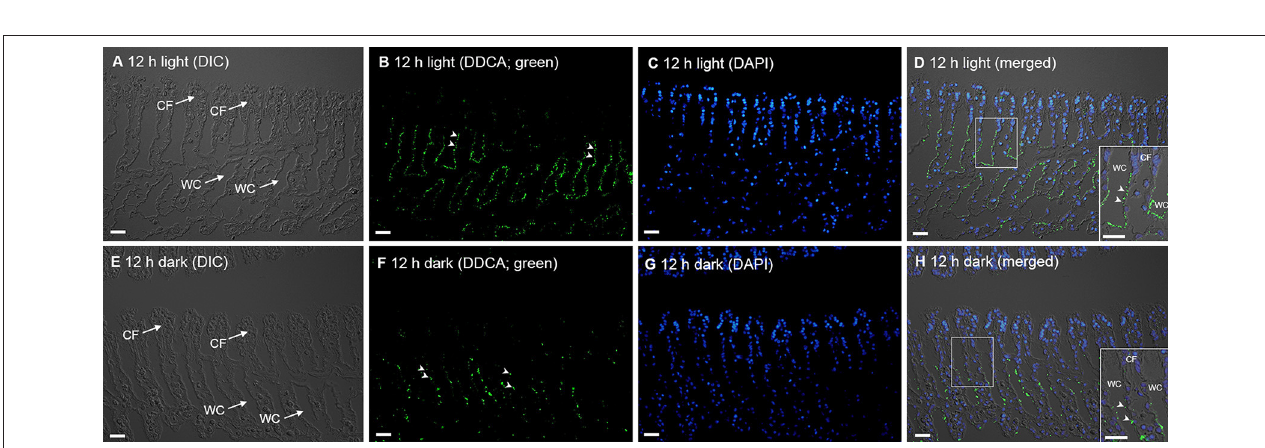
FIGURE 6 | Immunofluorescence localization of the Dual Domain Carbonic Anhydrase (DDCA) in the tertiary water channels (WCs) of the ctenidium of Tridacna squamosa . Immunofluorescence localization of the DDCA in the WCs of the ctenidium of T. squamosa exposed to 12h of light (A–D) or 12h of darkness (control; E–H ). Differential interference contrast (DIC) images show the lattice formation of WCs (A,E) . Anti-DDCA immunofluorescence is shown in green (B,F) with nuclei counterstained with DAPI in blue (C,G) . Green and blue channels are merged and overlaid with the respective DIC images (D,H) . Arrowheads indicate DDCA-immunostaining at the apical membrane of the epithelial cells surrounding the WCs. HL, hemolymph. Scale bar: 20 µ m. Reproducible results were obtained from four individual clams for each experimental condition.